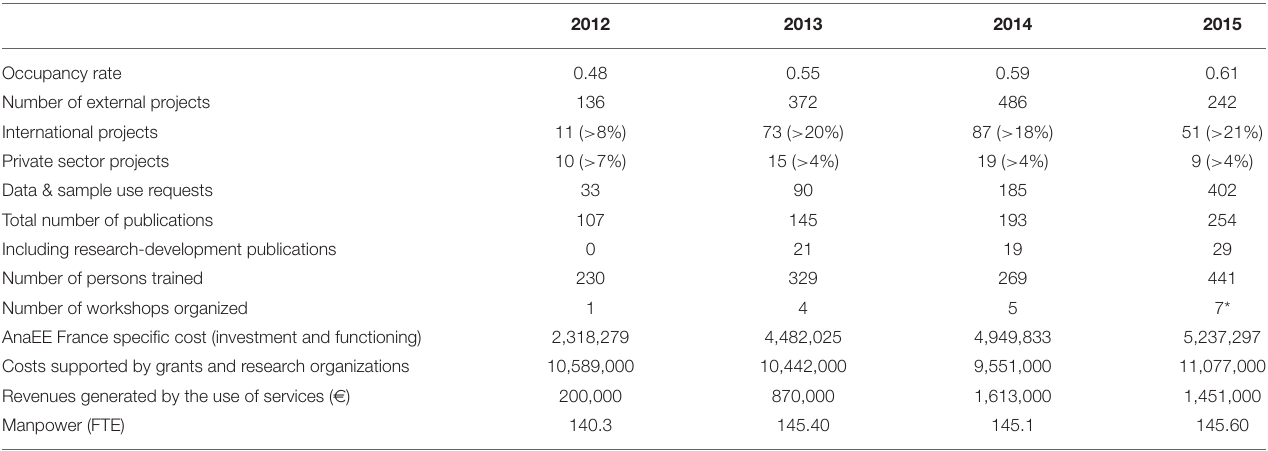
TABLE 1 | Performance indicators of AnaEE France since its construction in